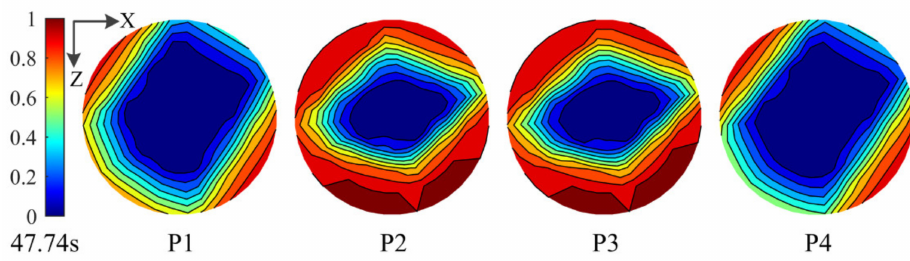
Figure 18. The compression damage of concrete in the core area at 47.74 s.